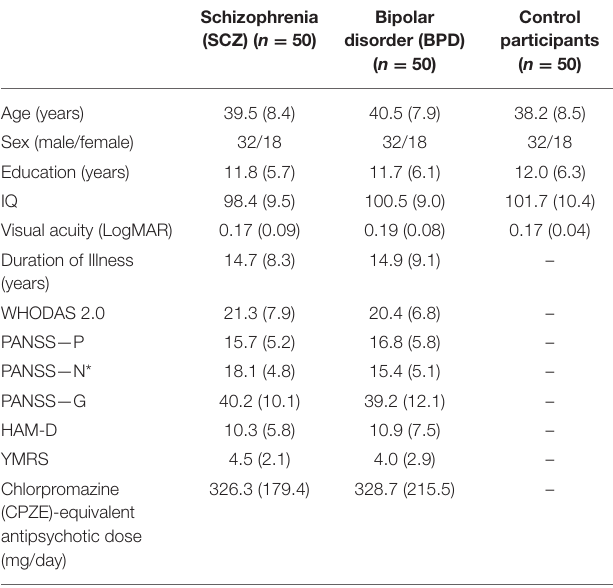
TABLE 1 | Clinical and demographical characteristics of the participants. Schizophrenia (SCZ) ( n =